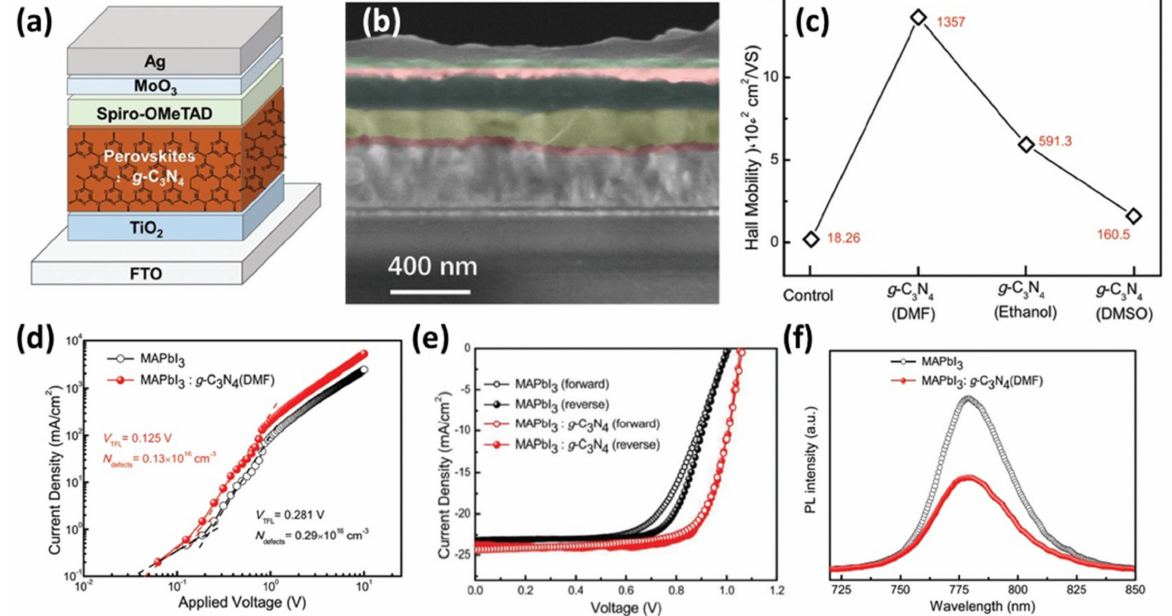
Figure 6. ( a ) Architecture of MAPbI 3 :g-C 3 N 4 based n-i-p PSC and ( b ) corresponding cross-sectional SEM image, ( c ) Hall mobility of MAPbI 3 and MAPbI 3 :g-C 3 N 4 in various solvents films, ( d ) current density–voltage (J–V) curves of hole- dominated devices with a structure of FTO/PEDOT:PSS/MAPbI 3 (with and without g-C 3 N 4 )/MoO 3 /Ag, ( e ) J–V curves of MAPbI 3 and MAPbI 3 :g-C 3 N 4 based devices by forward and reverse scan, and ( f ) photoluminescence (PL) spectra of MAPbI 3 and MAPbI 3 :g-C 3 N 4 (DMF) films deposited on TiO 2 /FTO. Reproduced with permission from [56], Copyright 2017, Wiley-VCH